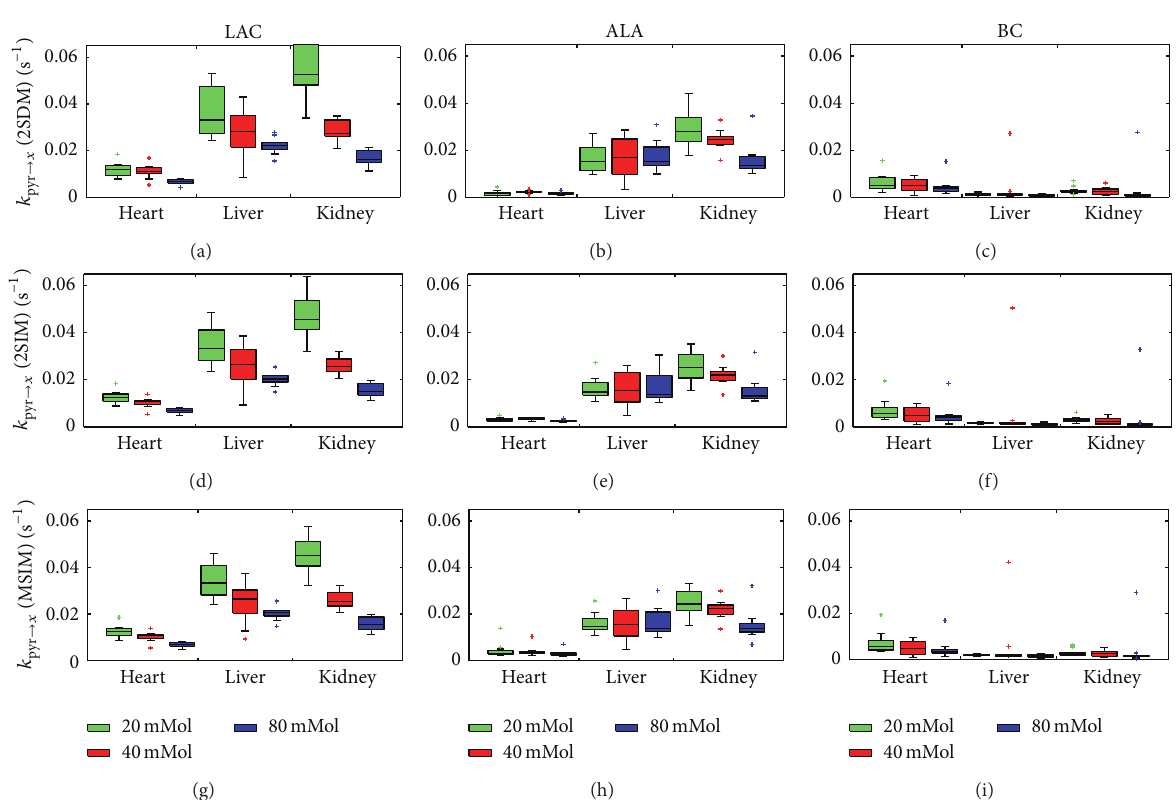
Figure 2: Metabolic conversion rates of LAC (left), ALA (center), and BC (right) obtained for heart, kidney, and liver predominant slices at 20, 40, and 80mM concentrations (0.1, 0.2, and 0.4mmol/kg doses) for 2SDM (top), 2SIM (center), and MSIM (bottom). Every box plot displays minima, 25th percentiles, medians, 75th percentiles, maxima, and